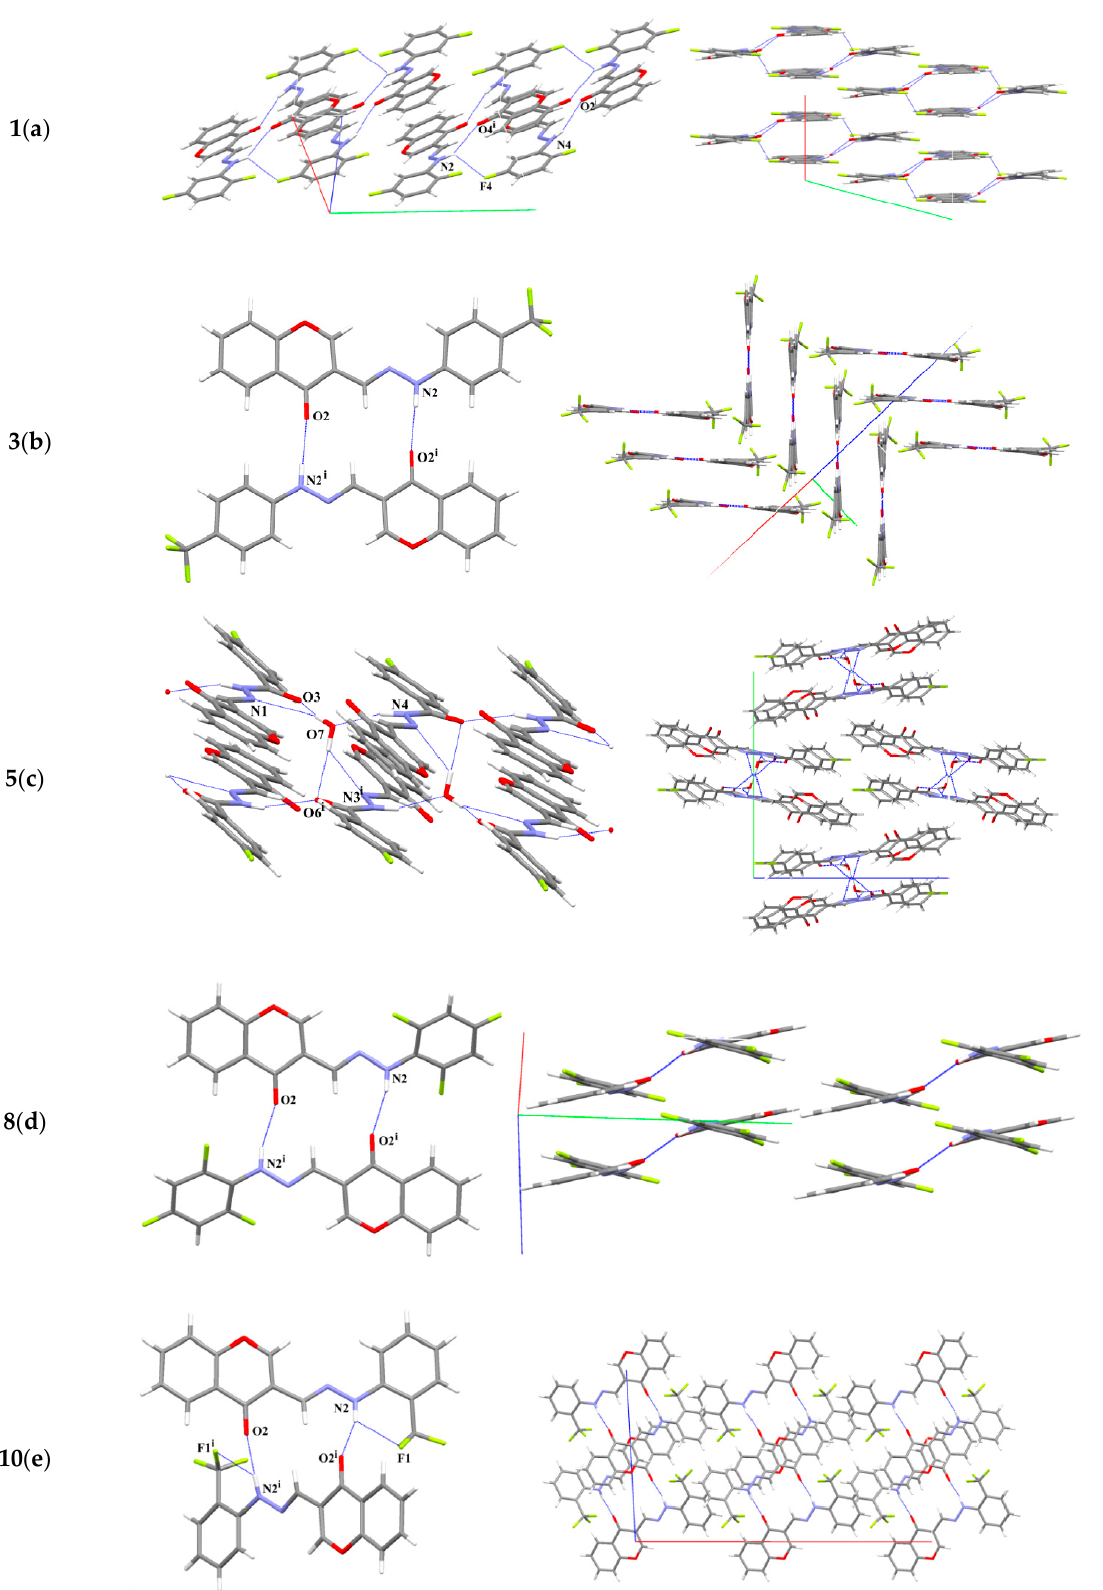
Figure 3. A part of the studied crystal structures showing characteristic hydrogen-bonded motifs ( left ) and their arrangement in the crystal lattices ( right ) of 1 ( a ), 3 ( b ), 5 ( c ), 8 ( d ) and 10 ( e ). Symmetry codes: under Table 2.